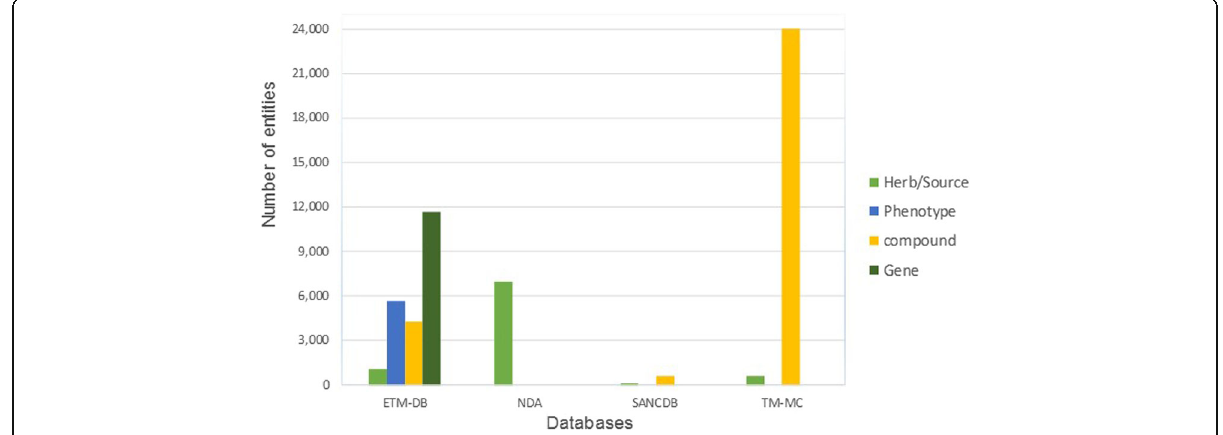
Fig. 5 Bar graph of comparison of the amount of ETM-DB main entities with related natural product databases